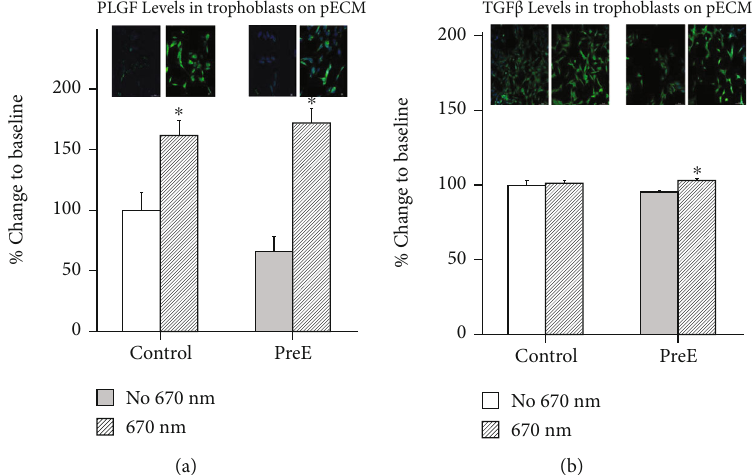
Figure 7: (a) 670 nm light increases expression level of Placental Growth Factor (PLGF) and (b) Transforming Growth Factor (TGF β ) in HTR8/SVneo cells when cultured on preeclamptic matrix; (a) PLGF expression. (b) TGF β expression ( p ≤ 0 : 05 , n = 4